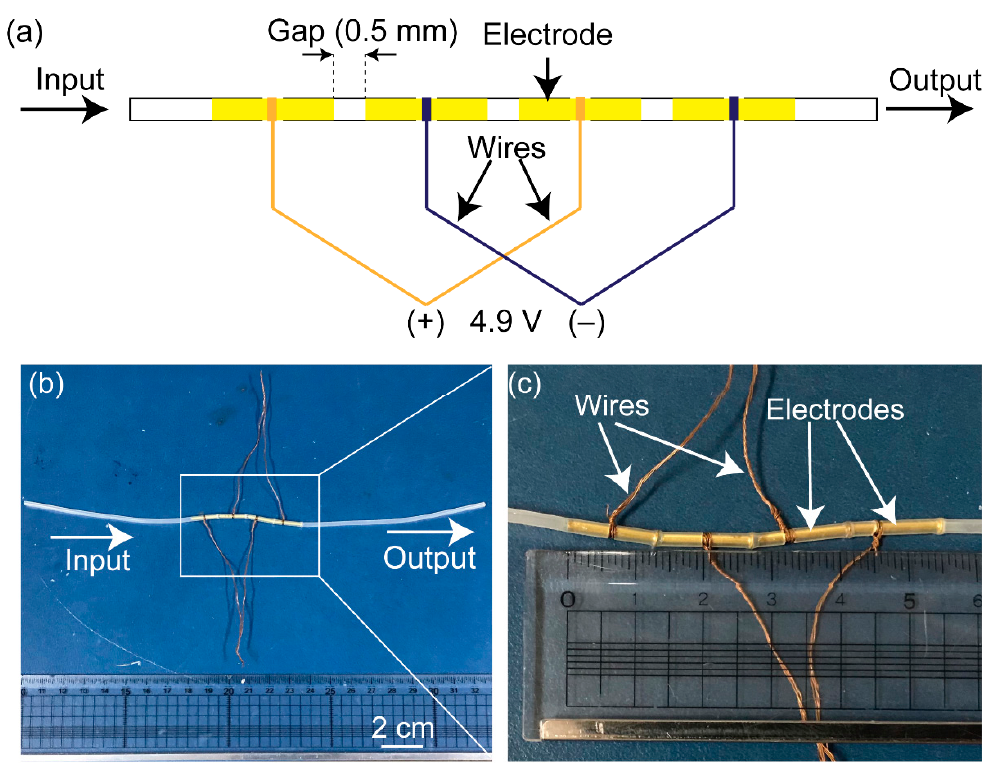
Figure 2. ( a ) Schematic of cell lysis device; photographs of the ( b ) device and ( c ) electrode